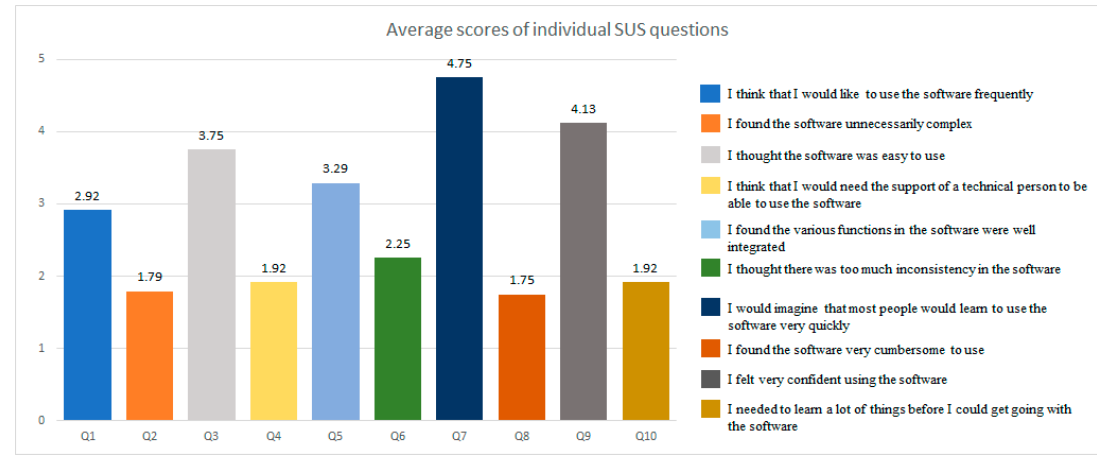
Figure 8. Average scores of individual responses to System Usability Scale (SUS) statements.